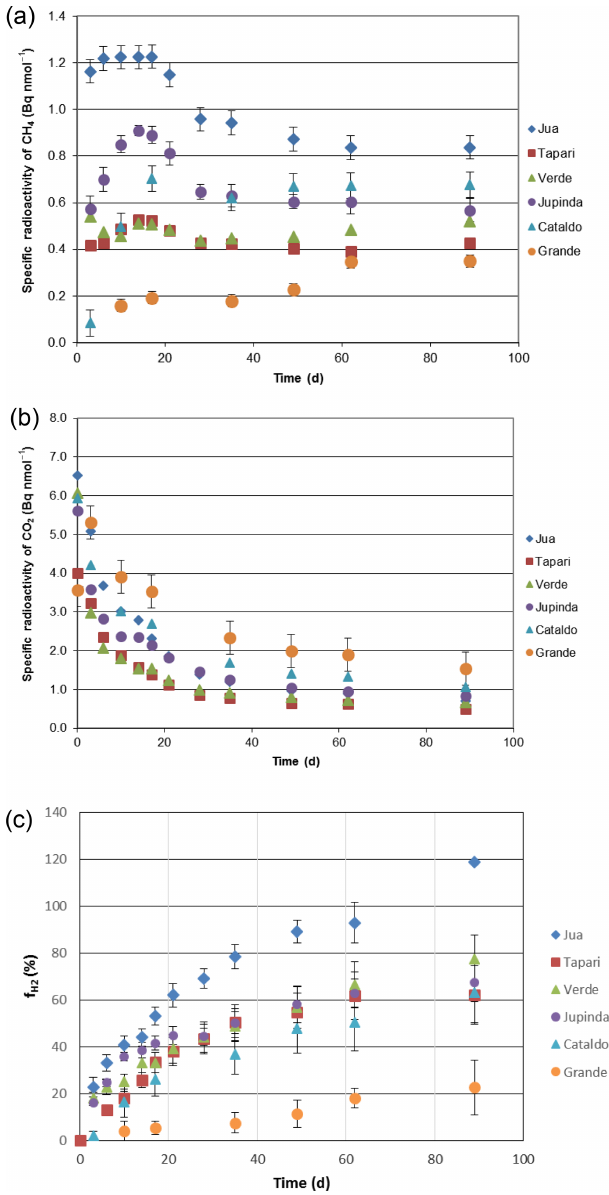
Figure 2. Conversion of radioactive bicarbonate in sediments of dif- ferent Amazonian lakes: (a) specific radioactivities in CH 4 , (b) spe- cific radioactivities in gaseous CO 2 and (c) fractions ( f H drogenotrophic methanogenesis (mean ±